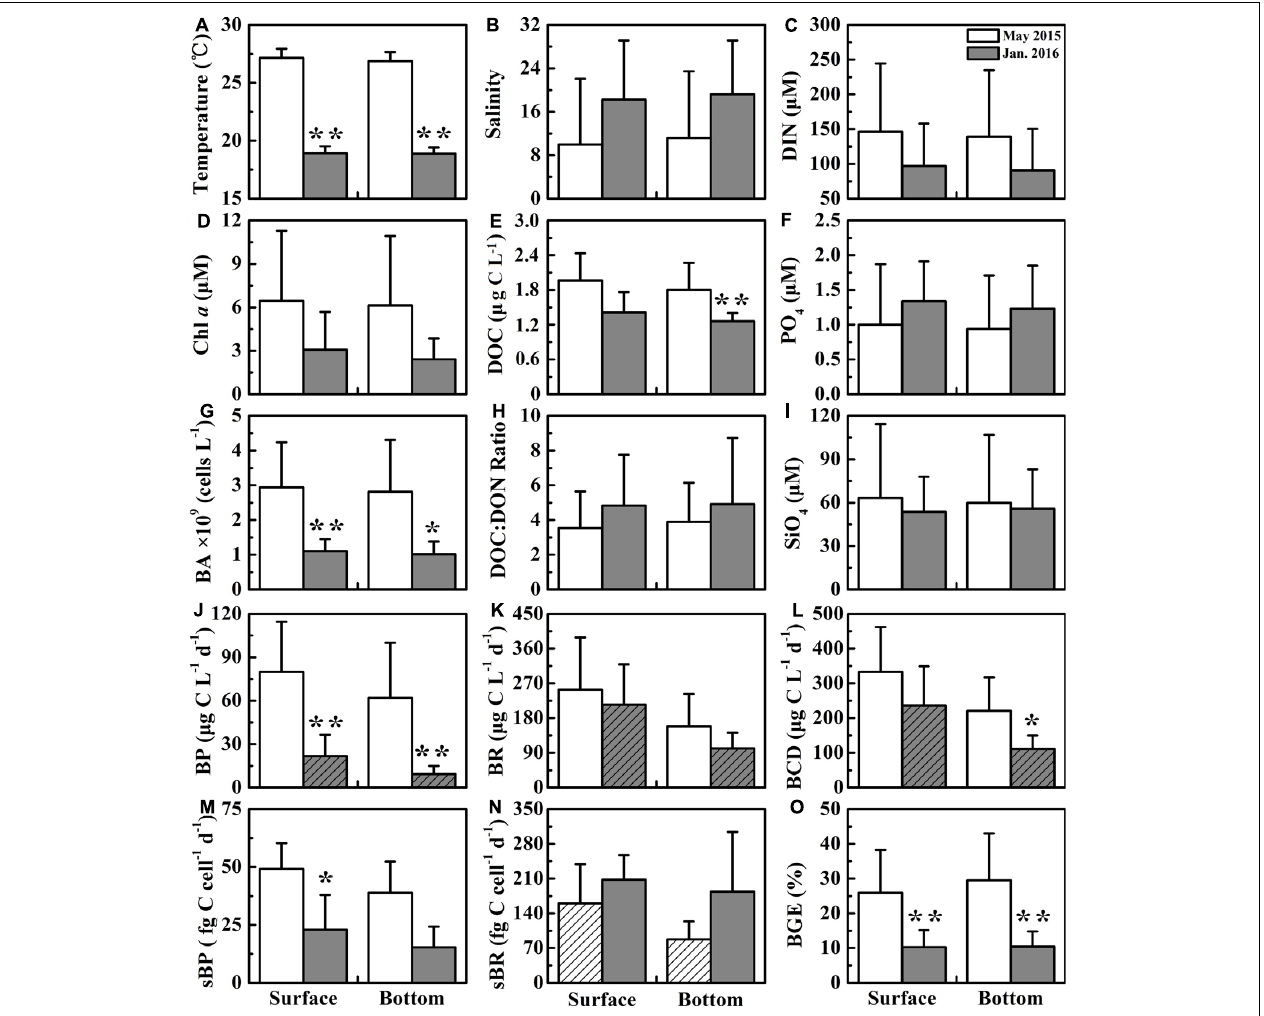
FIGURE 3 | The average of variables at the surface and the bottom in the wet season (May 2015) and the dry season (January 2016). ∗ and ∗∗ denote that variables between the wet season and the dry season are on average significantly different at 0.05 ( p < 0.05) and 0.01 ( p < 0.01), respectively. The columns filled by oblique lines showing significant difference ( p < 0.05) between the surface and the bottom in same season. The labels (A–O) are the number of each graph.